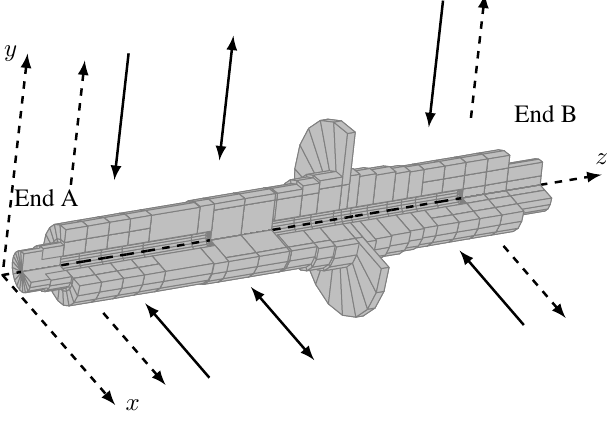
Figure 1. Rotor model with locations of radial sensor planes (dashed line with arrows), radial actuator planes (solid line with arrows) and motor (solid line with two arrows) in the active magnetic bearing (AMB) rotor